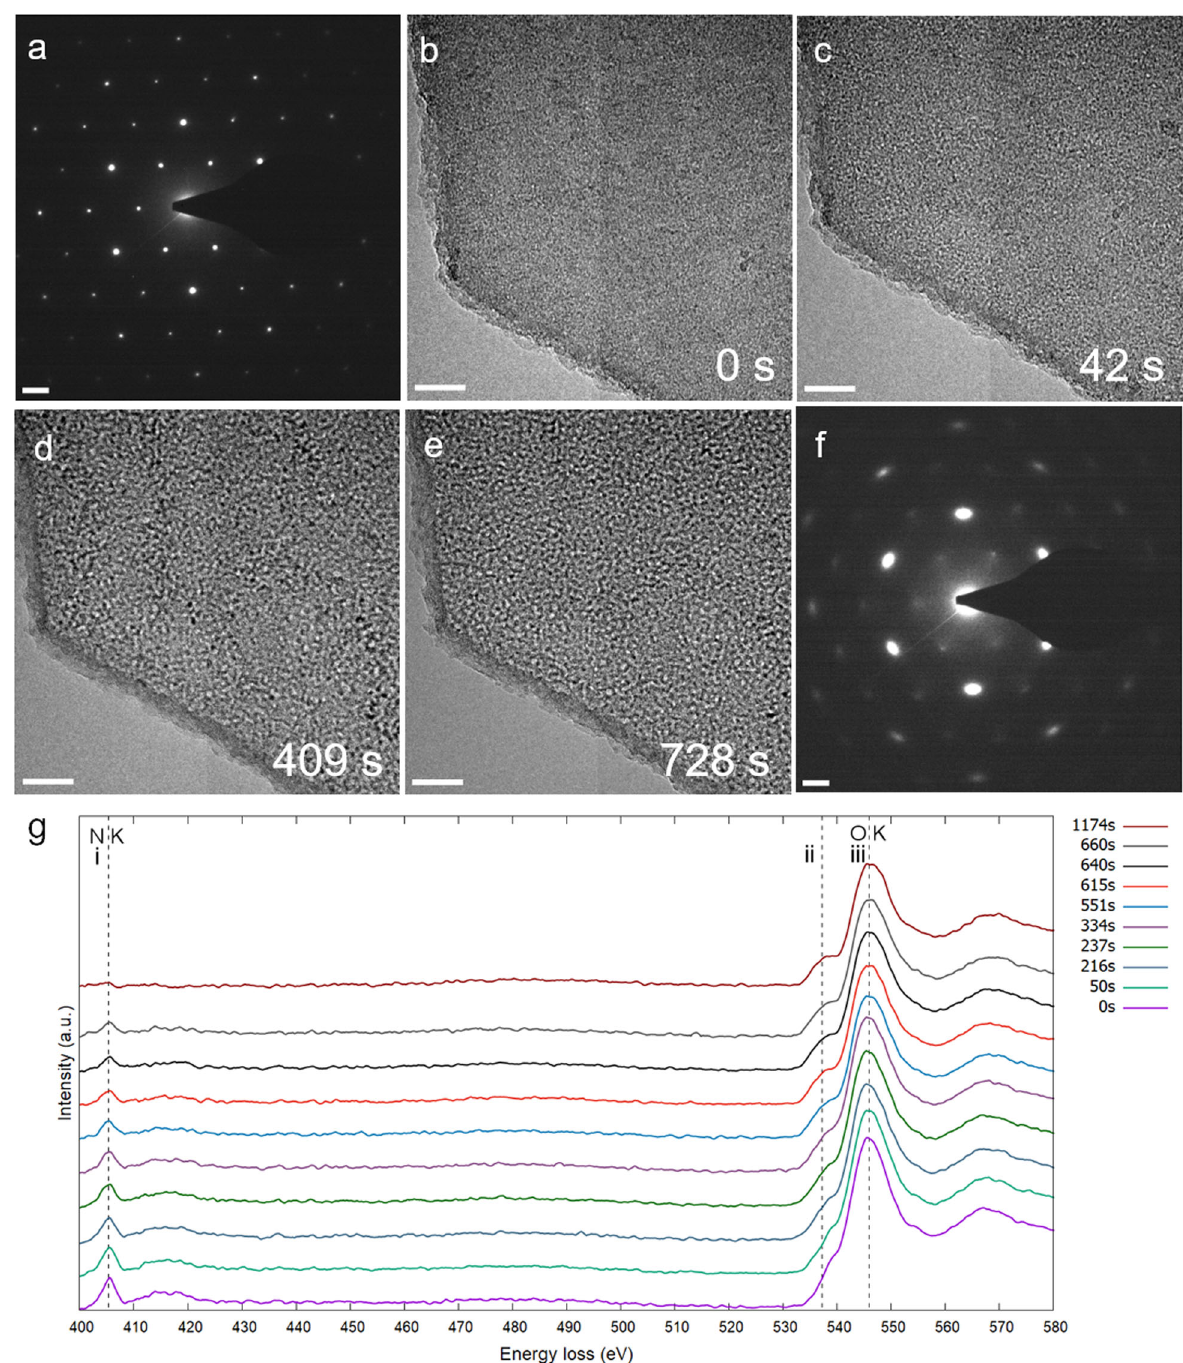
Fig. 3 Electron irradiation of Ni – Fe LDH at 300 kV. a , f SAED pattern recorded before and after irradiation by electron beam. b – e Time series TEM micrographs acquired of the same Ni – Fe LDH region. Images acquired after 0 s, 42 s, 409 s and 728 s of beam exposure respectively. g EELS spectra time series of the nitrogen K edge and oxygen K edge from 0 s to 1174 s. The time associated with each spectra represents the amount of irradiation time by the electron beam at acquisition. Scale bars are 2 nm − 1 for the SAED patterns and 20 nm for the BFTEM micrographs